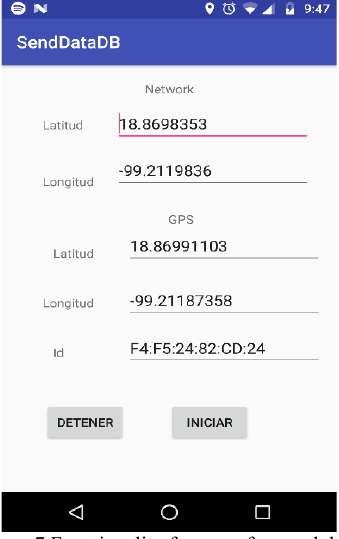
Figure 7 Functionality for georeferenced